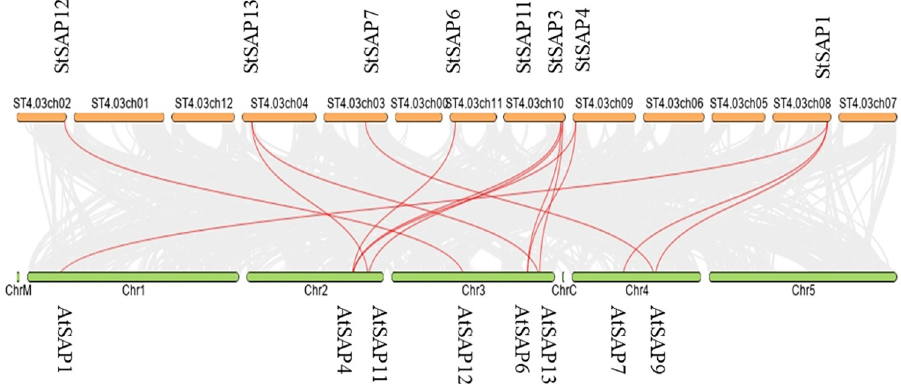
Fig 5. Synteny analysis between S . tuberosum and A . thaliana SAP genes. The chromosomes are represented by the horizontal bars and the curves show the linkage among the genes.